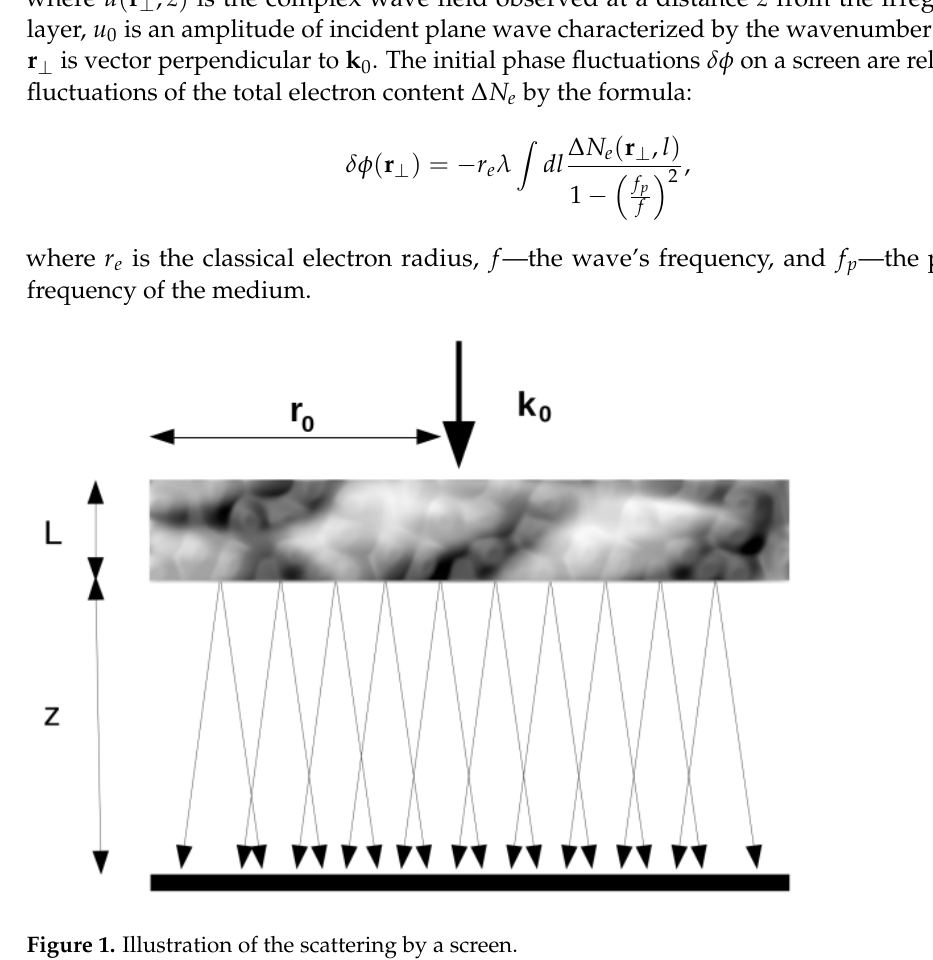
Figure 1. Illustration of the scattering by a